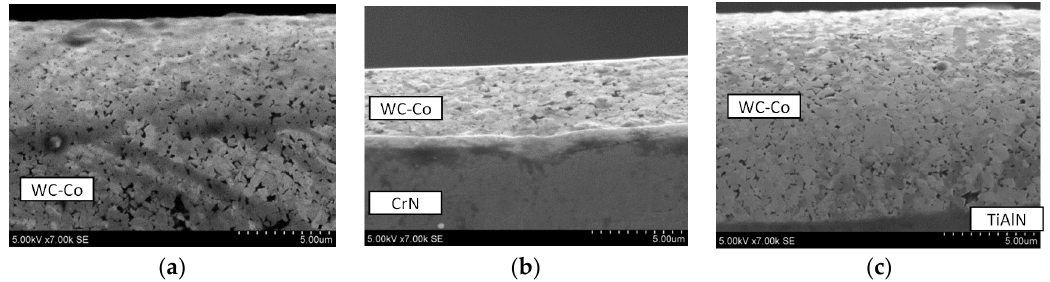
Figure 11. SEM images of the rake surface of the cutter of hard metal WC-Co with and without PVD coatings and the cutting edge after the 9050 m path (2.15 × 10 6 work cycles) (×7000): ( a ) WC-Co; ( b ) CrN; ( c ) TiAlN.